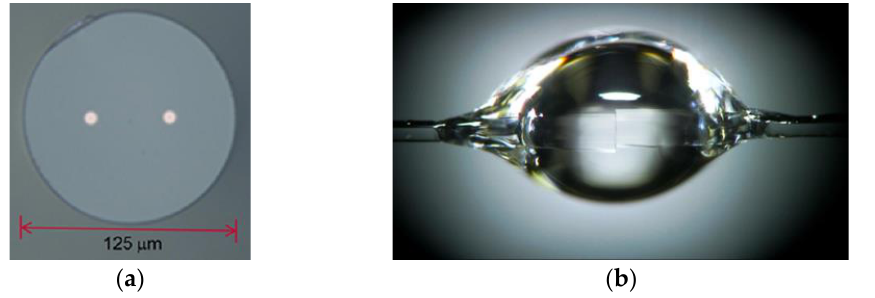
Figure 14. Images of cleaved end face of two-core MCF ( a ) and bonded with lateral offset standard single-mode and MCF ( b ).